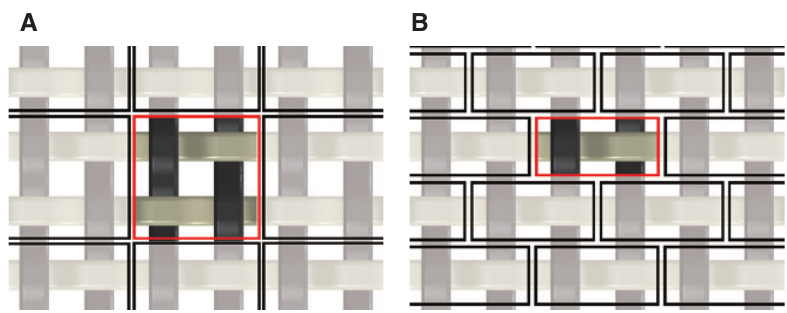
Figure 24: RUC and ORUC selected for plain weave composites.